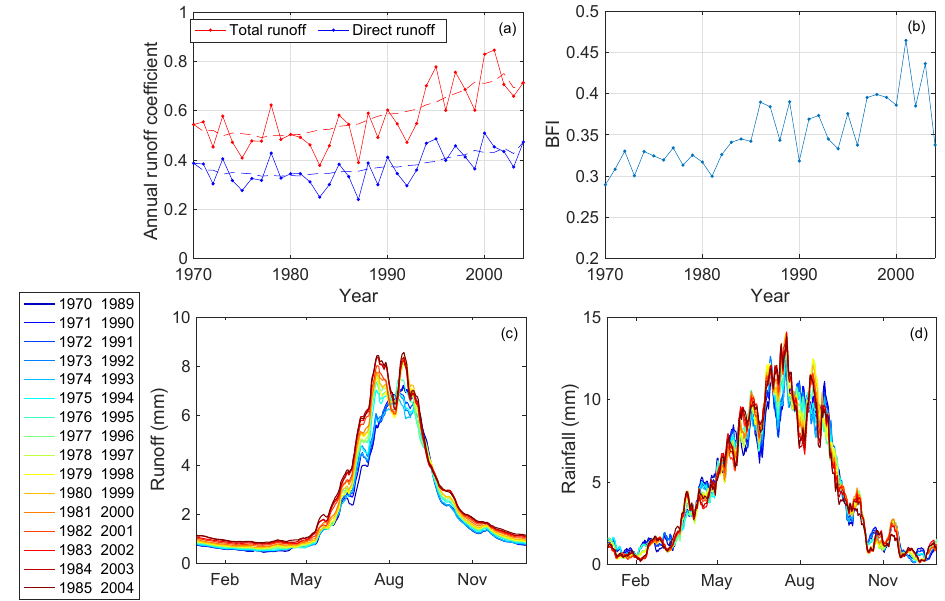
Figure 2. Impact of land use change on observed streamflow: (a) annual runoff coefficient, (b) annual baseflow index (BFI), (c) Moving Average over Shifting Horizon (MASH) results for total observed runoff and (d) MASH for observed